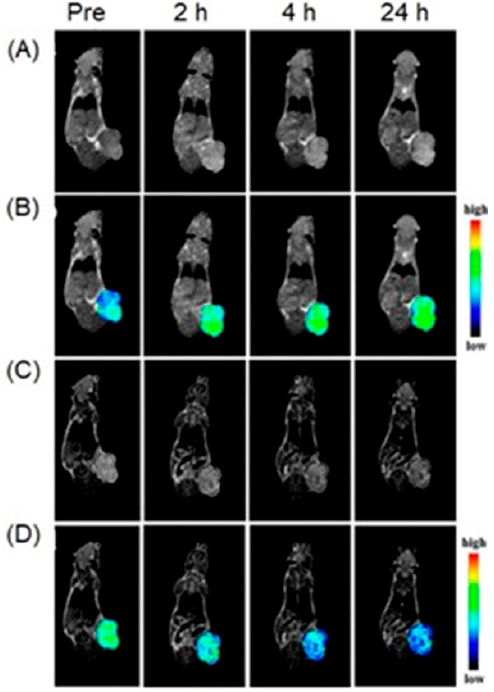
Figure 64. [( A , B )] T 1 -weighted and [( C , D )] T 2 -weighted MRI images of a tumor-bearing mouse be- fore and after intravenous injection of nanocomposites at different times. Adapted with permission from Jin, L.; Liu, J.; Tang, Y.; Cao, L.; Zhang, T.; Yuan, Q.; Wang, Y.; Zhang, H. MnO 2